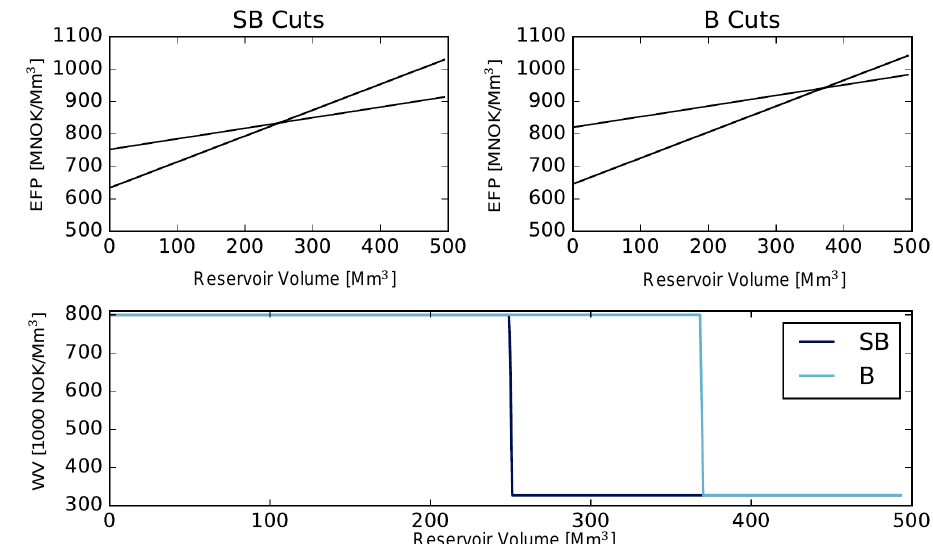
Figure 8. Illustration of the B and SB cuts and how this affects the water